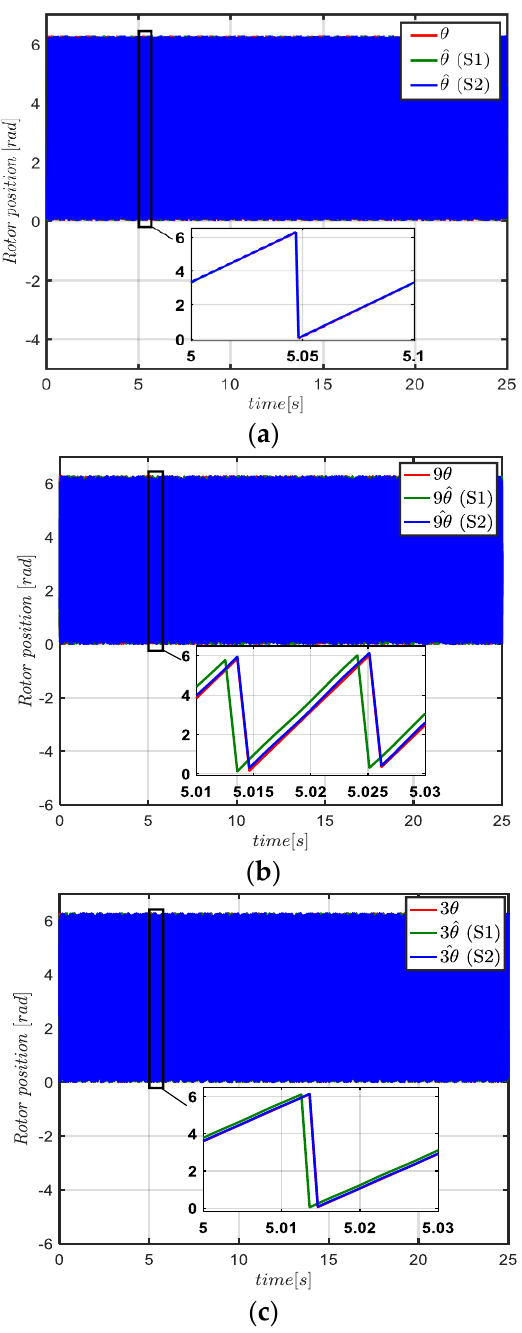
Figure 24. Experimental waveforms: measured and estimated rotor positions using ( S1 ) and ( S2 ): ( a ) angle required to control MM, ( b ) angle required to control SM, ( c ) angle required to control TM.